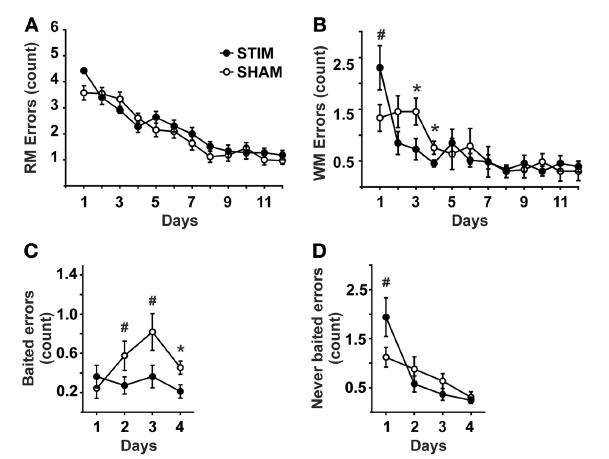
FIGURE 1 | Behavioral measures (mean ± s.e.m.). (A) Reference memory errors. (B) Working memory errors. (C) Working memory errors made on baited arms ( = re-entries into baited arms where the bait has been consumed already within the ongoing trial). (D) Working memory errors made on never baited arms ( = re-entries into never baited arms within the ongoing trial). • Represent STIM condition, ◦ represent SHAM condition. ANOVAs for repeated measures followed by post-hoc t -tests. ∗ p < 0 . 05, # p < 0 . 1.